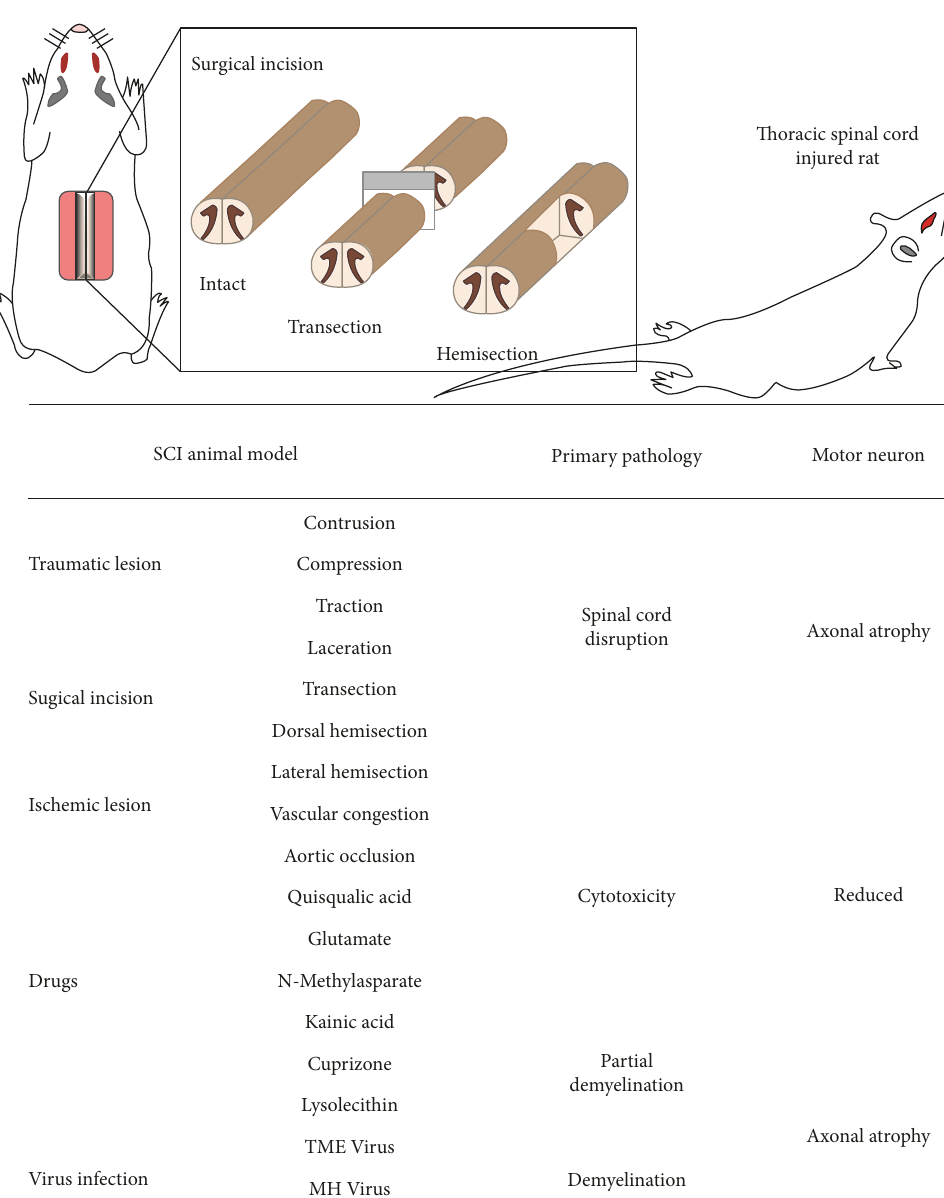
Figure 1: Development of animal models of spinal cord injury. (Upper illustration) methods for inducing spinal cord injury via surgical incision include transection and hemisection, both of which can be accomplished using a surgical knife (left). Hind limb paralysis following thoracic spinal cord injury in rats (right). (Lower table) animal models categorized by lesion method (left), the resulting primary pathology (middle), and fi nal result of a ff ected motor neurons